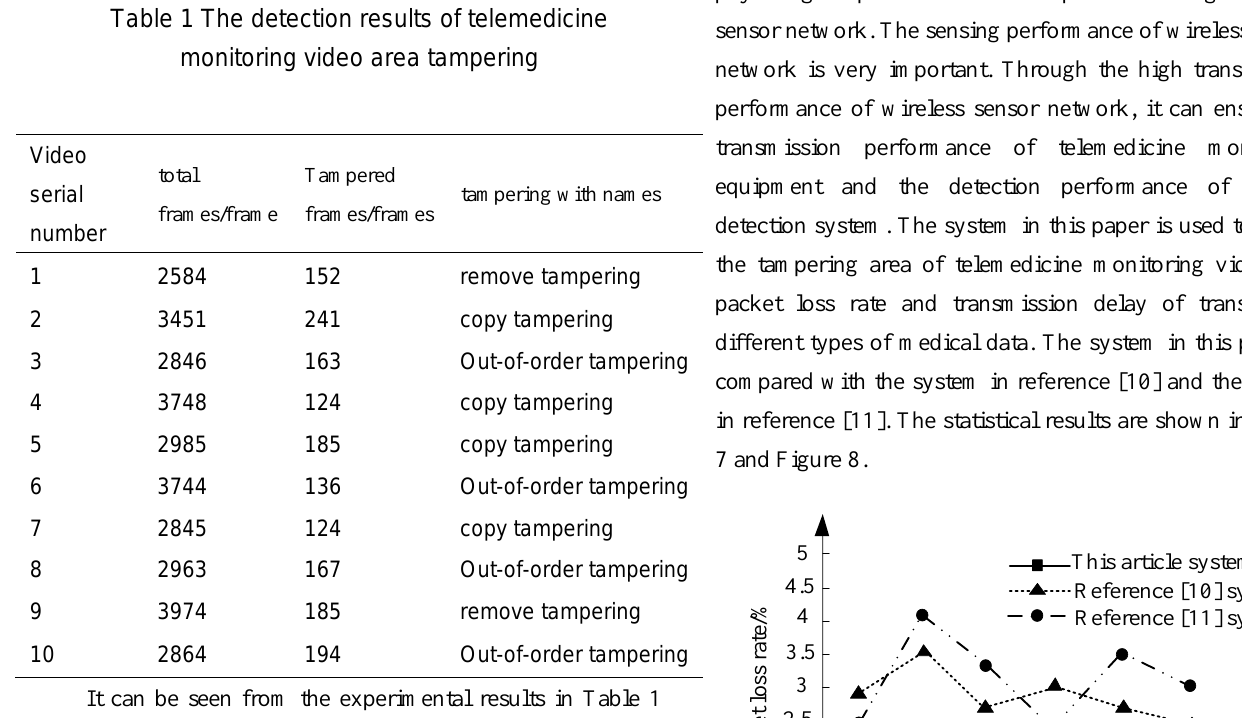
Table 1 The detection results of telemedicine